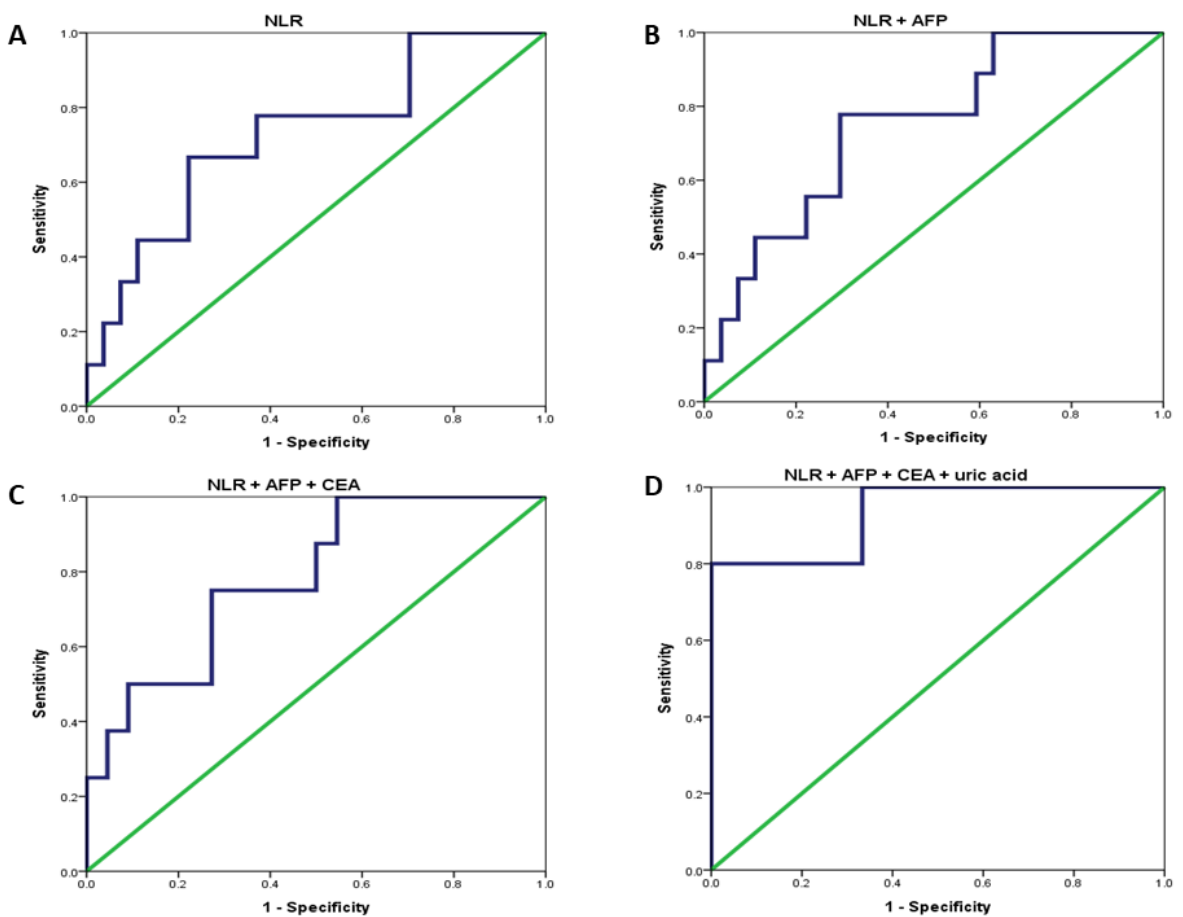
Figure 2. Performance of Biomarkers in Predicting CK19 expression in HCC illustrated as Area Under the ROC (AUROC). ( A ) NLR; ( B ) NLR + AFP; ( C ) NLR + AFP + CEA; ( D ) NLR + AFP + CEA + uric acid.